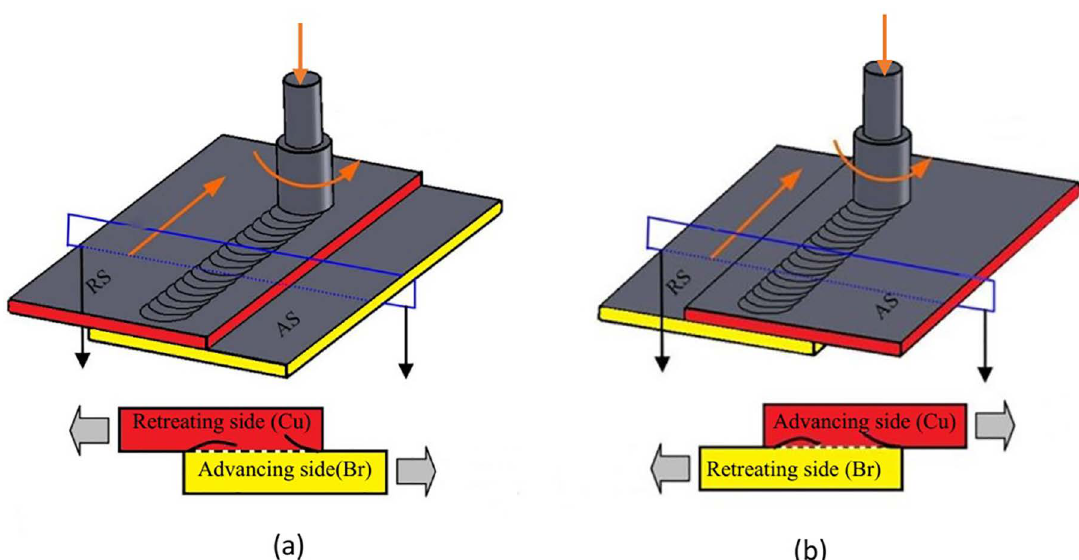
Figure 2. Schematic of FSW Cu-Brass lap joints when Cu plates were fixed on: (a) advancing side (AS), (b) retreating side (RS). Table 2. The FSW welding parameters Sample